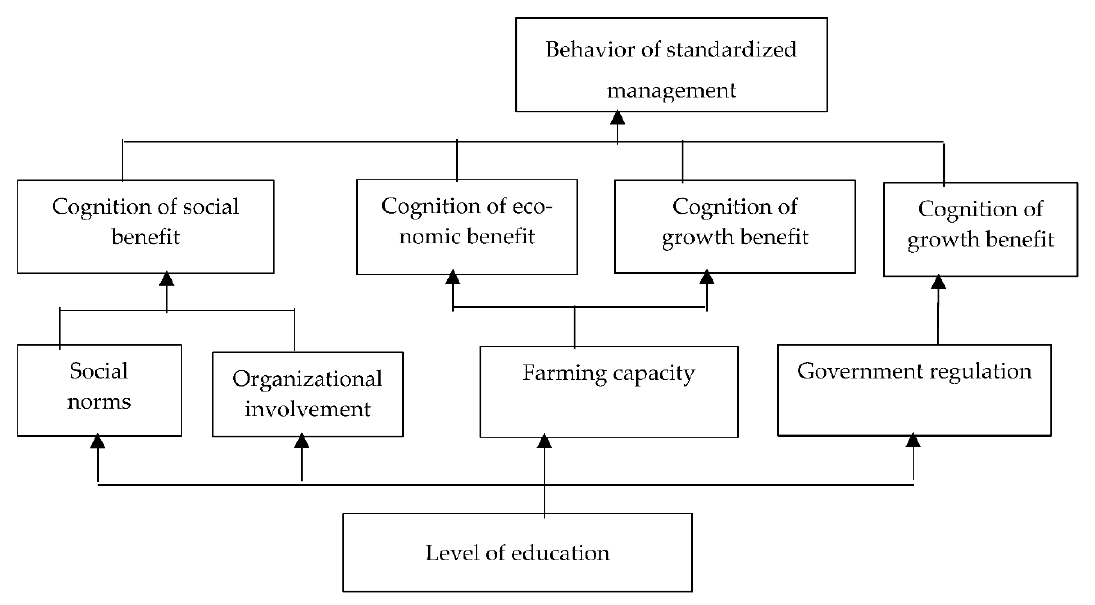
Figure 5. Correlation and Hierarchical Structure Among Influencing Factors of Standardized Management.